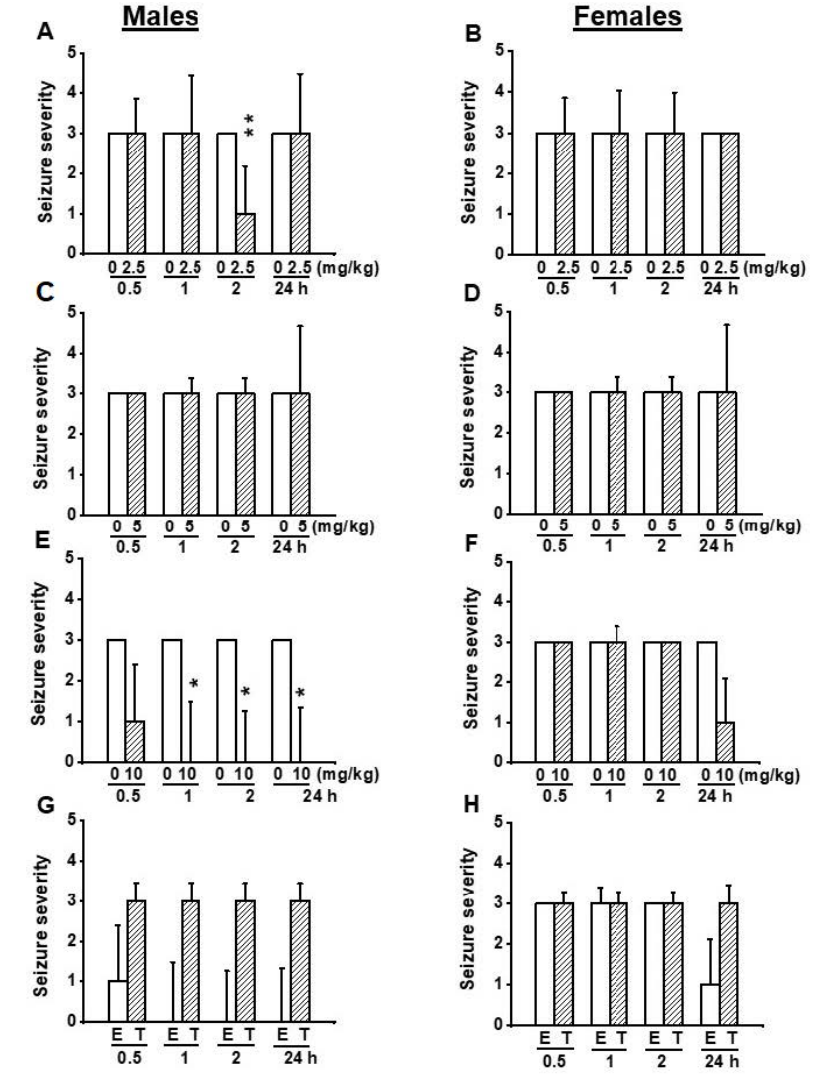
Figure 2. Effects of acute treatment with EACT (E) and T16Ainh-A01 (T), a potent blocker of TMEM16A channels, on the severity of acoustically evoked seizures. The effects of EACT, a potent activator of TMEM16A channels, on the seizure severity were evaluated at various doses (2.5, 5, and 10 mg/kg, p.o.), and at different post-treatment time points (0.5, 1 h, 2 h, and 24 h) in adult male and female GEPR-3s. T16Ainh-A01 was tested only at the dose of 10 mg/kg, p.o.) and the data were compared with EACT (10 mg/kg, p.o.) ( A ) EACT treatment significantly reduced the seizure severity at the 2 h post-treatment time point in males. ( B ) EACT treatment did not alter the seizure severity in females. ( C ) EACT treatment significantly suppressed the seizure severity at 2 and 2 h post-treatment time points in males. ( D ) EACT treatment did not considerably alter the seizure severity in females. ( E ) EACT treatment significantly suppressed the seizure severity at 1, 2, and 24 h post-treatment time points in males. ( F ) EACT treatment did not considerably alter the seizure severity in females. ( G ) In males, T16Ainh-A01 treatment (T) reversed the antiseizure effects following EACT administration (E), but no statistical significance was reached. ( H ) In females, T16Ainh-A01 did alter the effects of EACT. The seizure severity data were represented as median ± median average deviation, and the Wilcoxon signed-rank test was used to compare paired EACT data or T16Ainh-A01 data, and the Mann-Whitney test was used to compare the EACT and T16Ainh-A01 groups. Opened and filled bar graphs represent control-treated (pre-EACT) and EACT treated GEPR-3s ( n = 9), respectively. * p < 0.05, ** p <